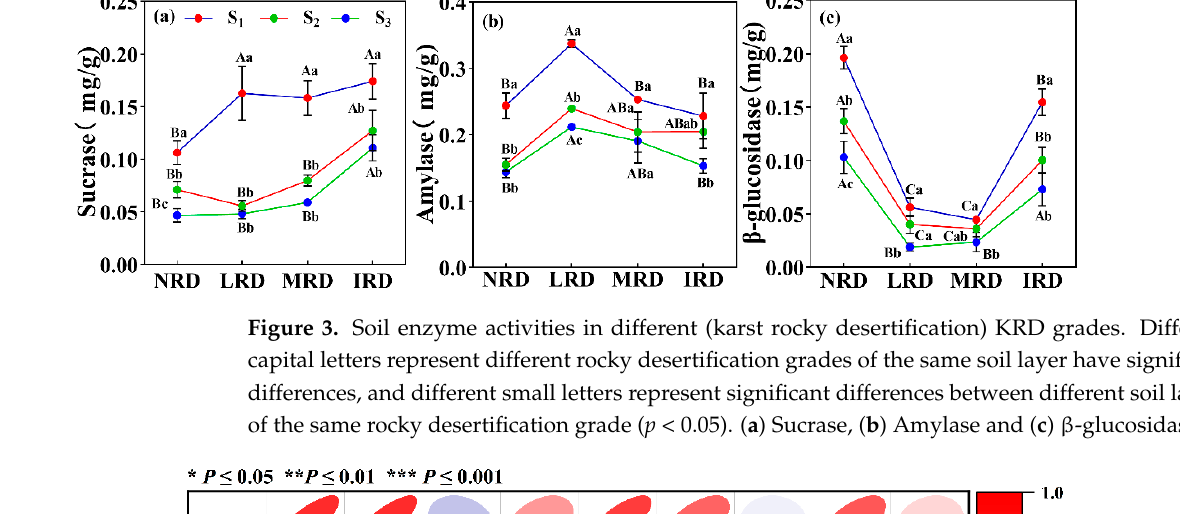
Table 4. Communalities, weight and norm value of environmental factors based on minimum da- taset (MDS) and total dataset (TDS), respectively. COM: communalities.